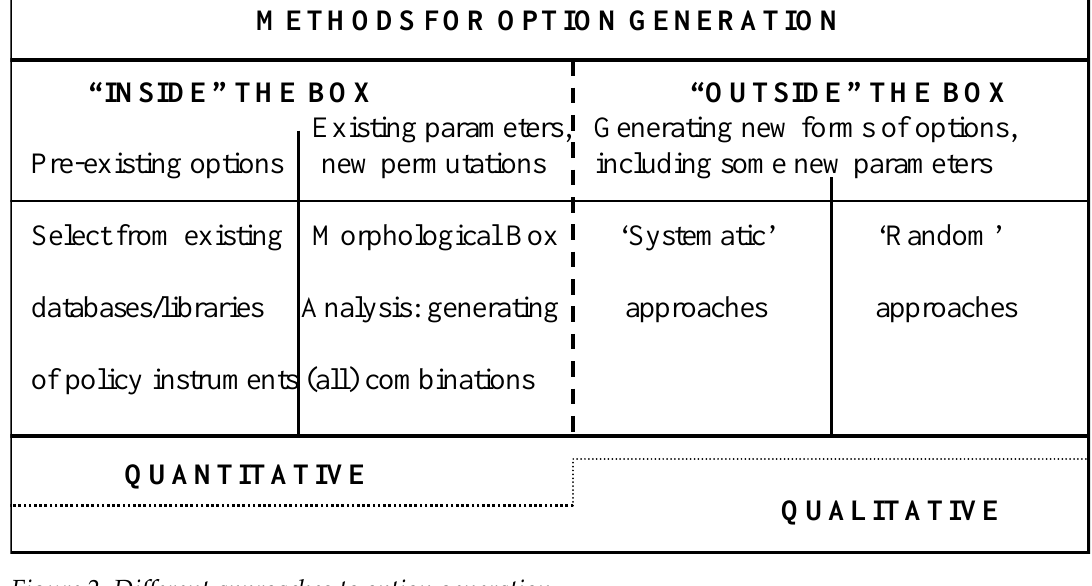
Figure 2. Different approaches to option generation Source: derived from Jones and Lucas, 2005, Figure